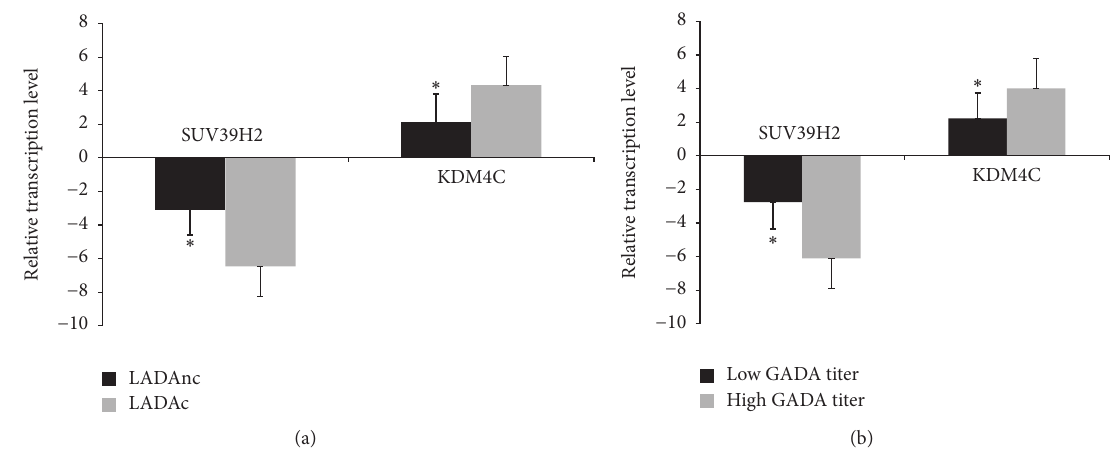
Figure 4: An association of complication and GADA titer with the expression of SUV39H2 and KDM4C in CD4 + T lymphocytes from LADA patients was visible. (a) Relative mRNA levels of histone methyltransferase SUV39H2 and demethylase KDM4C in CD4 + T lymphocytes from LADA patients, ∗ 𝑃 < 0.05 , LADA patients with complications (LADAc, 𝑛 = 14 ) versus LADA patients without complications (LADAnc, 𝑛 = 12 ). (b) Relative mRNA levels of histone methyltransferase SUV39H2 and demethylase KDM4C in CD4 + T lymphocytes from LADA patients, ∗ 𝑃 < 0.05 , LADA patients with low GADA titer ( 𝑛 = 17 ) versus LADA patients with high GADA titer ( 𝑛 = 9